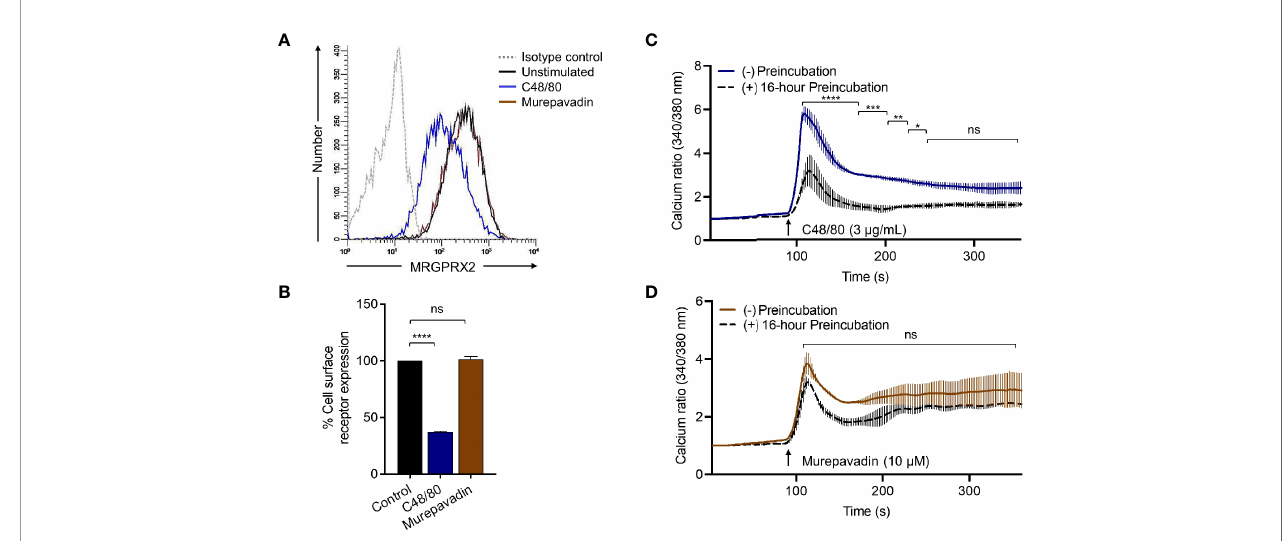
FIGURE 5 | Murepavadin does not induce MRGPRX2 internalization or desensitization. (A) RBL-MRGPRX2 cells were exposed to MRGPRX2 ligand (C48/80 3 m g/ mL or murepavadin 10 m M, 16 h) and cell surface receptor expression of MRGPRX2 was con fi rmed using fl ow cytometry. A representative histogram of MRGPRX2 cell surface receptor expression is shown. (B) Quantitative analysis of cell surface receptor expression was calculated using a mean fl uorescent intensity (MFI) in comparison to the untreated control. (C, D) Calcium mobilization measurements of RBL-MRGPRX2 cells exposed to MRGPRX2 ligand (C48/80 3 m g/mL or murepavadin 10 m M, 16 h) following C48/80 (3 m g/mL) or murepavadin (10 m M) stimulation, respectively. Statistical signi fi cance was determined by one-way ANOVA with Dunnett ’ s multiple comparisons and two-way ANOVA with S ̌ ı ́ da ́ k ’ s multiple comparisons at a value * p < 0.05, ** p < 0.01, *** p < 0.001, **** p < 0.0001, and ns denotes “ not signi fi cant ”